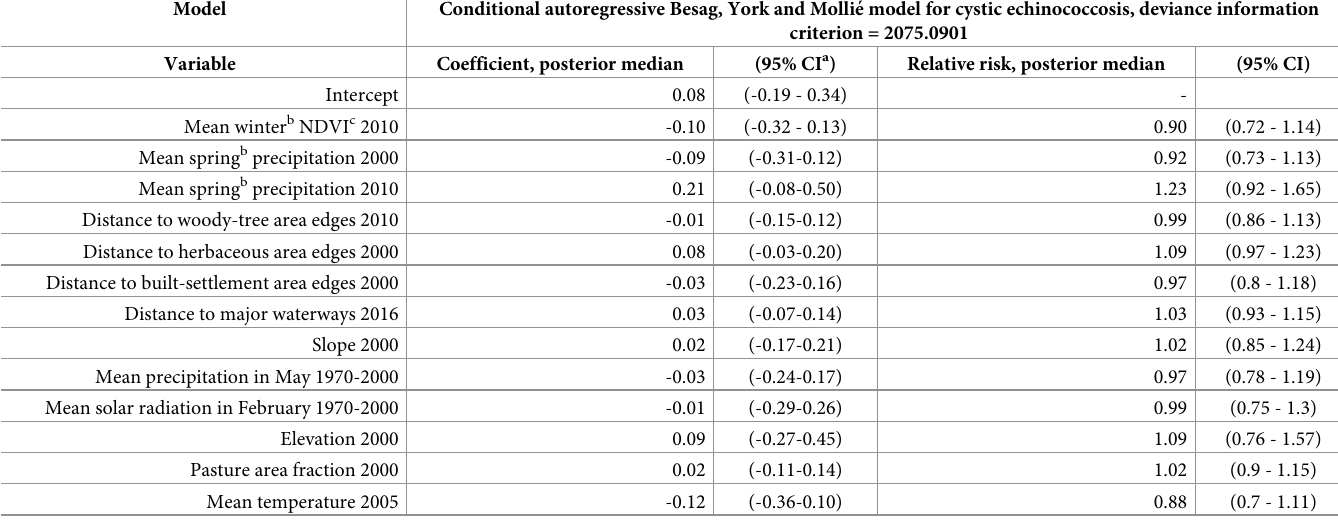
Table 3. Variables, regression coefficients (posterior medians), relative risk, 95% credible intervals from conditional autoregressive Besag, York and Mollie´ model for cystic echinococcosis in Kyrgyzstan, 2014-2016.